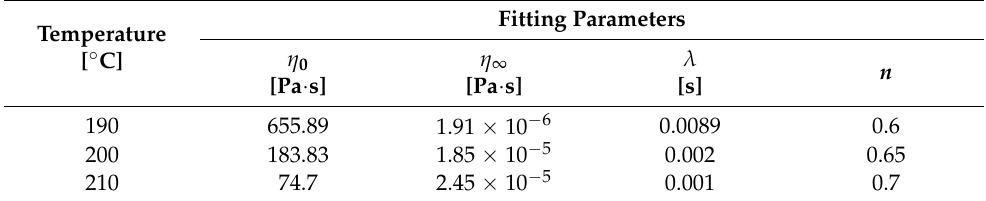
Table 2. Shear viscosity parameters in Carreau model after curve fitting.